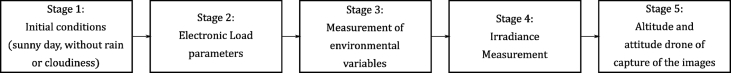
Images acquisition protocol.